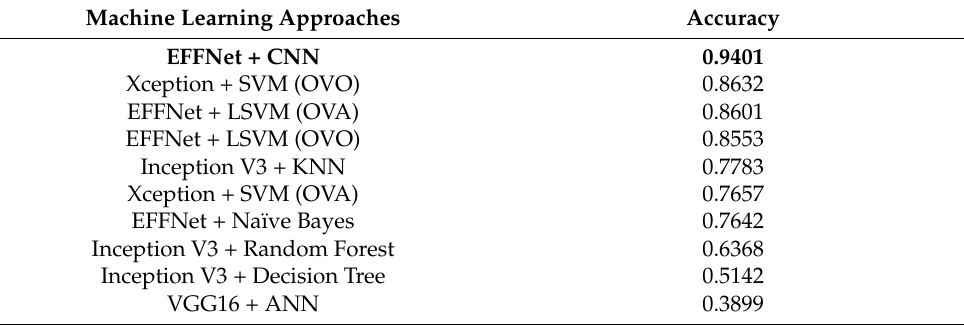
Table 20. The highest accuracy based on classifier for Sabah Food